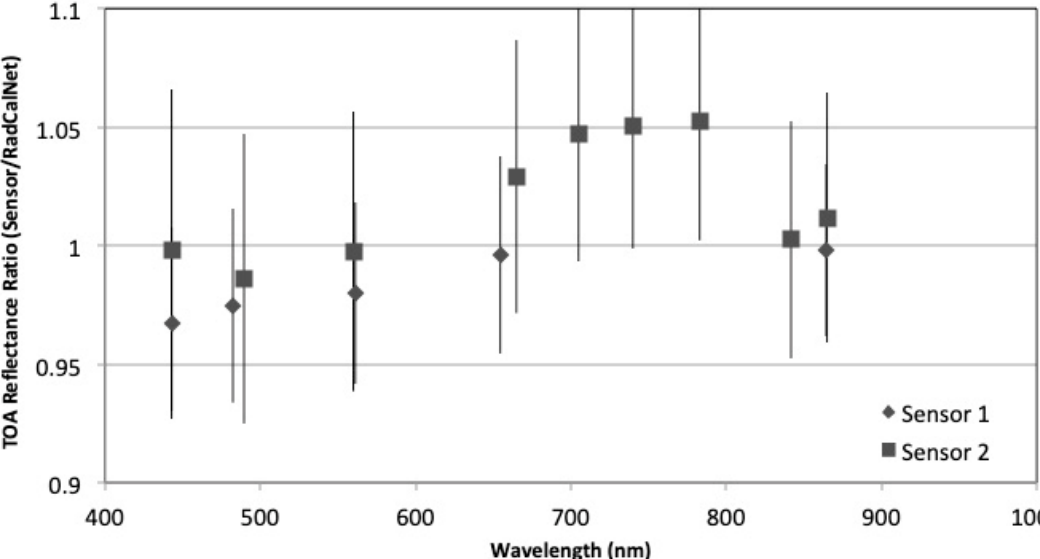
Figure 12. Average ratios of RadCalNet predicted TOA reflectance to reported values from Sensors #1 and #2 from the combination of both Sites A and B weighted by the absolute uncertainty for each site. The error bars shown are a weighted variance based on the absolute uncertainties for each site.